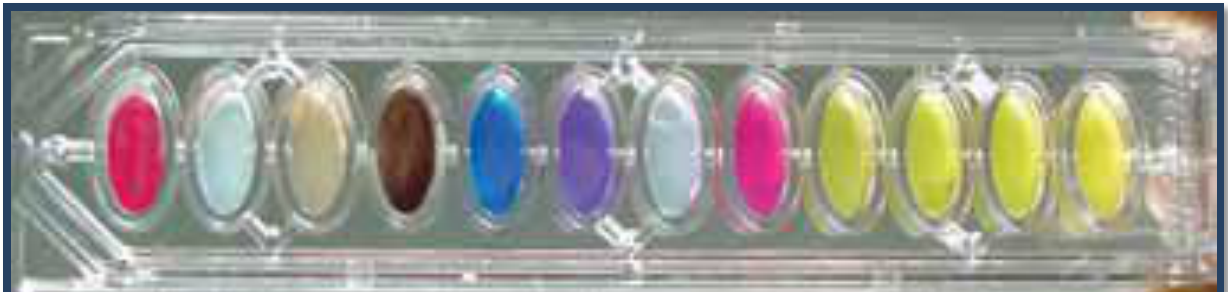
Figure, 1: KB011 HiSalmonella TM Identification Kit before inoculation